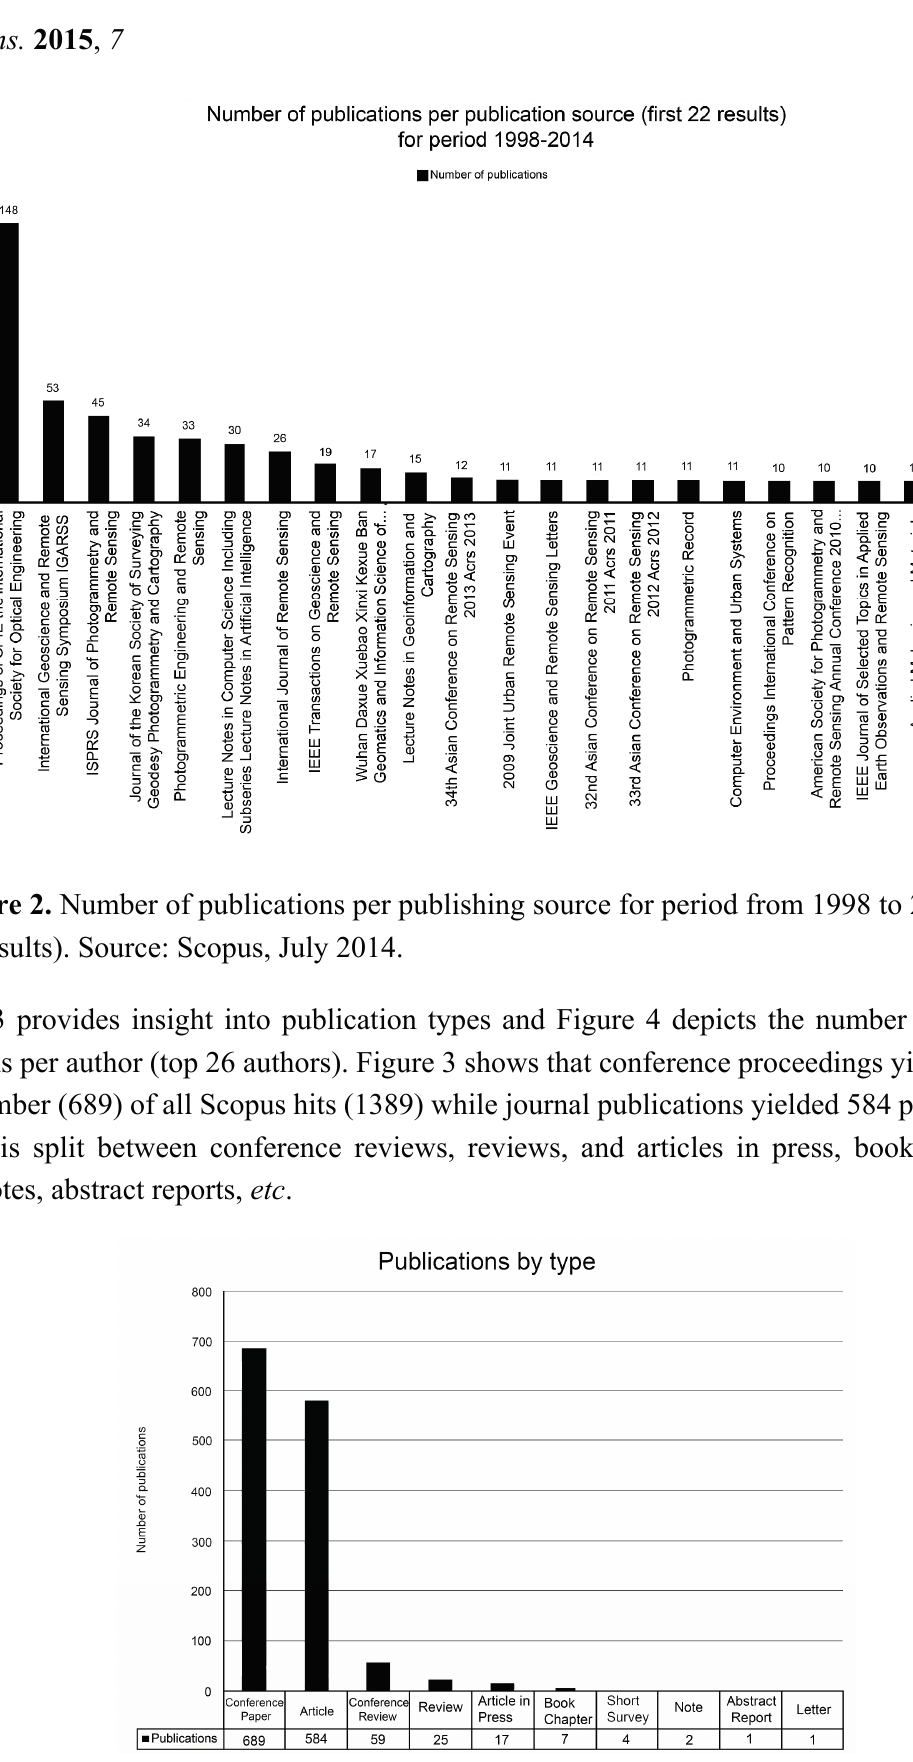
Figure 3. Number of publications per type of publication for period from 1998 to 2014 (source: Scopus, July